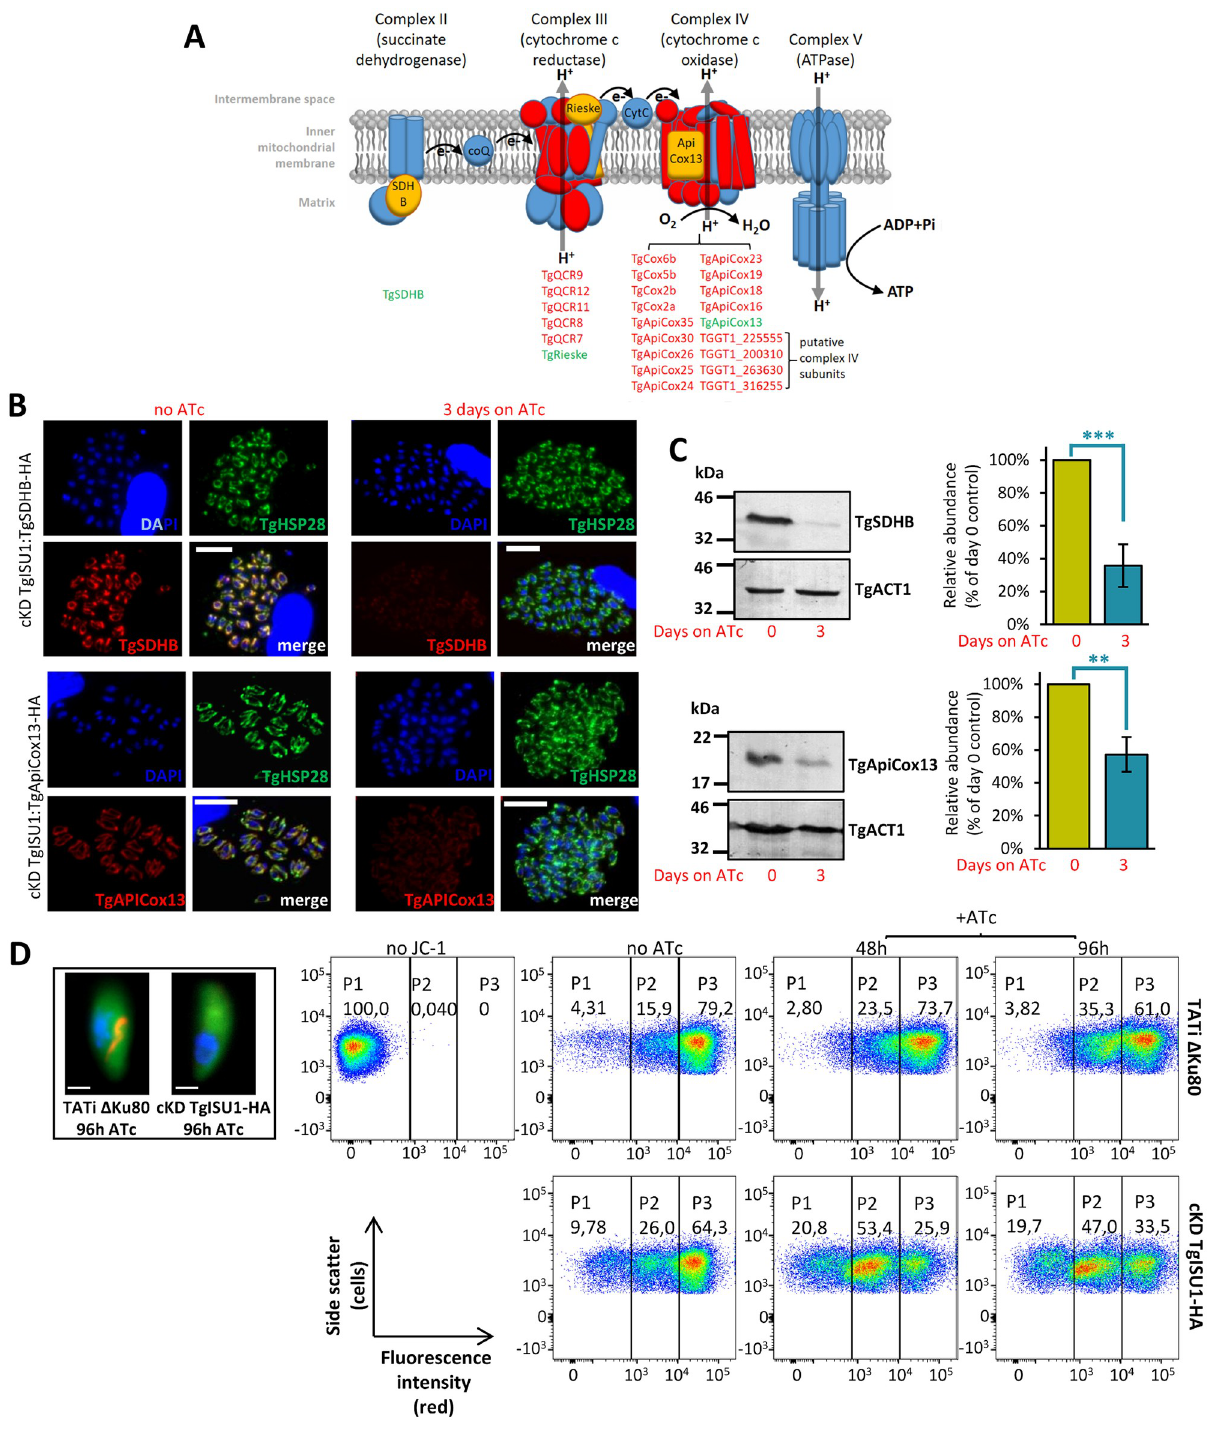
Fig 8. TgISU1 depletion impacts the mitochondrial respiratory chain. A) Schematic representation of the T . gondii mitochondrial respiratory chain; listed are the subunits of the different complexes that were found less abundant upon TgISU1 depletion; Fe-S proteins are highlighted in green. SDH: succinate dehydrogenase; CoQ: coenzyme Q B) Immunofluorescence analysis of cKD TgISU1 parasites expressing HA-tagged TgSDHB (top) or TgApiCox13 (bottom) showing a decrease in expression in the HA-tagged candidates after 3 days of incubation with ATc. Images were taken with the same exposure time for similar channels. TgHSP29 was used as a mitochondrial marker. Scale bar represents 10 μ m. DNA was labelled with DAPI. C) Immunoblot analysis of TgSDHB (top) and TgApiCox13 (bottom) levels upon depletion of TgISU1 after 3 days of incubation with ATc. TgACT1 was